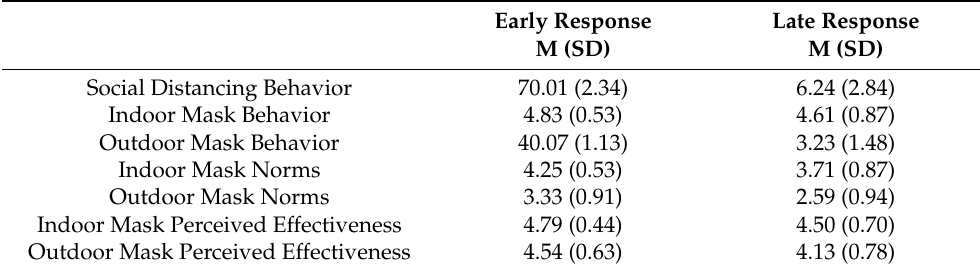
Table 3. Means and standard deviations of COVID-19 safety protocol behavior engagement, per- ceived norms, and perceived effectiveness by state response